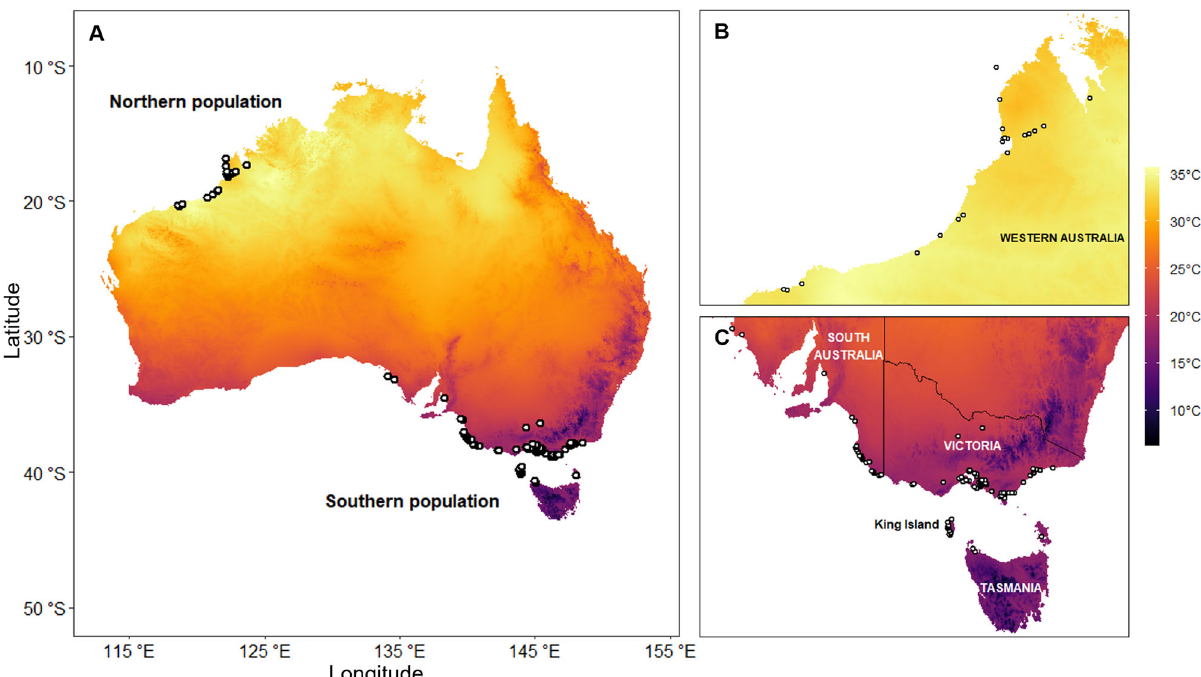
Fig. 1 | Sampling locations for Australian shorebirds. Field sites for shorebird researchconductedby theVWSGand AWSGin A northern and southernAustralia. Colour scale shows annual average daily maximum temperatures. B Northern populations were studied in hot, tropical coastal sites near Broome while